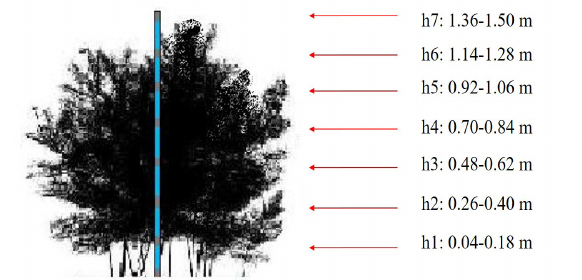
Figure 2. The PVC tube installed inside the asparagus canopy. Notice the polyethylene sheets placed at different heights from the ground (h1-h7) . Table 2. Copper deposit means (ppm) in function to treatments and sampling height. Nozzle tilt